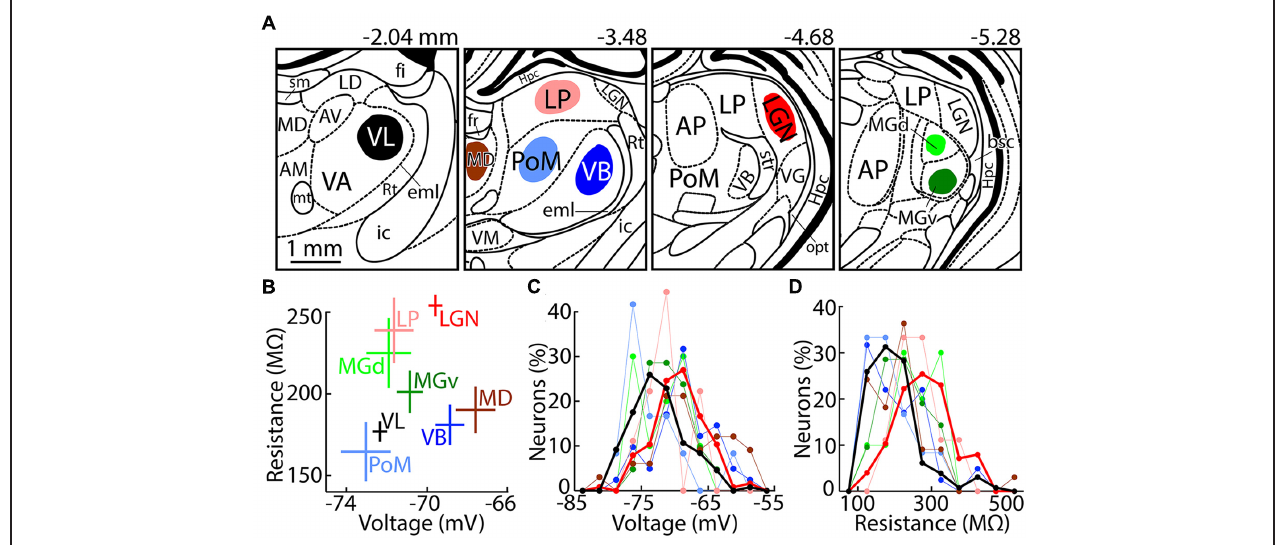
FIGURE 1 | Recording locations and passive membrane properties. (A) Drawings of coronal sections made using the atlas of Paxinos and Watson (2007), with distance from Bregma indicated above. Neurons were recorded in the colored regions, as listed in Table 1 . Nuclei that are labeled but were not recorded are AM (anteromedial), AP (anterior pretectal), AV (anteroventral), LD (laterodorsal), Hpc (hippocampus), Rt (reticular thalamus), VA (ventral anterior), VG (lateral geniculate nucleus, ventral division), and VM (ventromedial). Fiber tracts are bsc (brachium superior colliculus), eml (external medullary lamina), fi (fimbria of the hippocampus), fr (fasciculus retroflexus), ic (internal capsule), mt (mammillothalamic tract), opt (optic tract), sm (stria medullaris), and str (superior thalamic radiation). (B) Population (mean ± SEM) resting membrane potential and input resistance of thalamic nuclei. Numbers of contributing neurons correspond to the totals in Table 2 . (C) Histogram of resting potentials. Bin size, 2.5 mV. Thicker lines emphasize VL (black) and LGN (red). (D) Same as (C) but showing input resistances. Bin size, 50 M (cid:2)